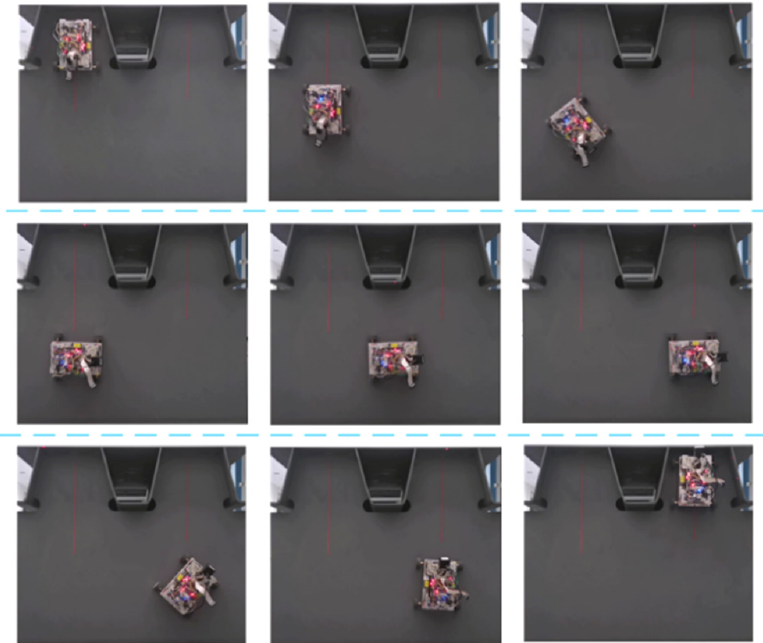
Figure 15. Experiment of the robot steering to next lane.